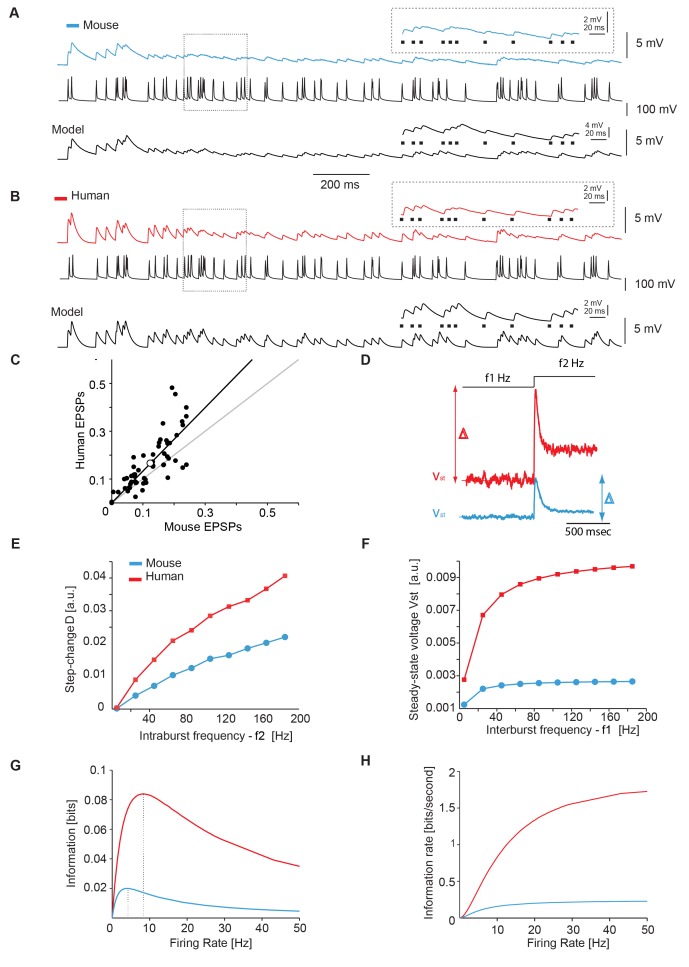
Fast recovering synapses transfer more information.(A,B) Unitary EPSPs in synaptically connected pyramidal neurons of mouse (A, blue) and human (B, red) neocortex generated by a presynaptic Poisson spike train (black). Inset shows enlargement of postsynaptic responses (average of 15 repetitions) to individual presynaptic APs (black dots). Lower traces show model simulations based on the Tsodyks-Markram model [17] with average parameters from experiments in Figure 1. (C) Normalized EPSP amplitudes in human versus mouse pyramidal neurons in response to each corresponding AP in the Poisson spike train in (A) and (B). Gray line has unitary slope, whereas the slope of the fit is 1.33±0.13. Differences are significant with p<0.05. Open circle represents the mean and standard deviations (smaller than circle diameter). (D–F) The steady-state membrane potential Vst or its transient change Δ was simulated for human and rodent synapses (D), in response to a step increase of the average APs frequency of afferents, active as independent Poisson spike trains. The value of Δ is plotted for increasing values of f2 (with f2 = 5 Hz) (E), while the value of Vst is plotted for increasing values of f1 (with f1 = f2) (F), as predicted by the Tsodyks-Markram model with parameters identified from the experiments. (G,H) Combining the quantal release model of synaptic transmission with the Tsodyks-Markram description, the transfer properties of short-term depressing synapses can be quantified by information theory. Over a broad range of firing frequencies, the mutual information, calculated between peak EPSP amplitudes and presynaptic interspike intervals, reveals a peak at an optimal firing frequency (G); Dividing the mutual information by the firing frequency, the information rate was plotted (H). (Data deposited in the Dryad repository, http://doi.org/10.5061/dryad.3723p
[56]: Raw data underlying (A) and (B) in Poisson_Human.rar and Poisson_Mouse.rar; Matlab code that generated (C–H) as well as Figure S2 in Code_Fig3_and_SFig2.rar).